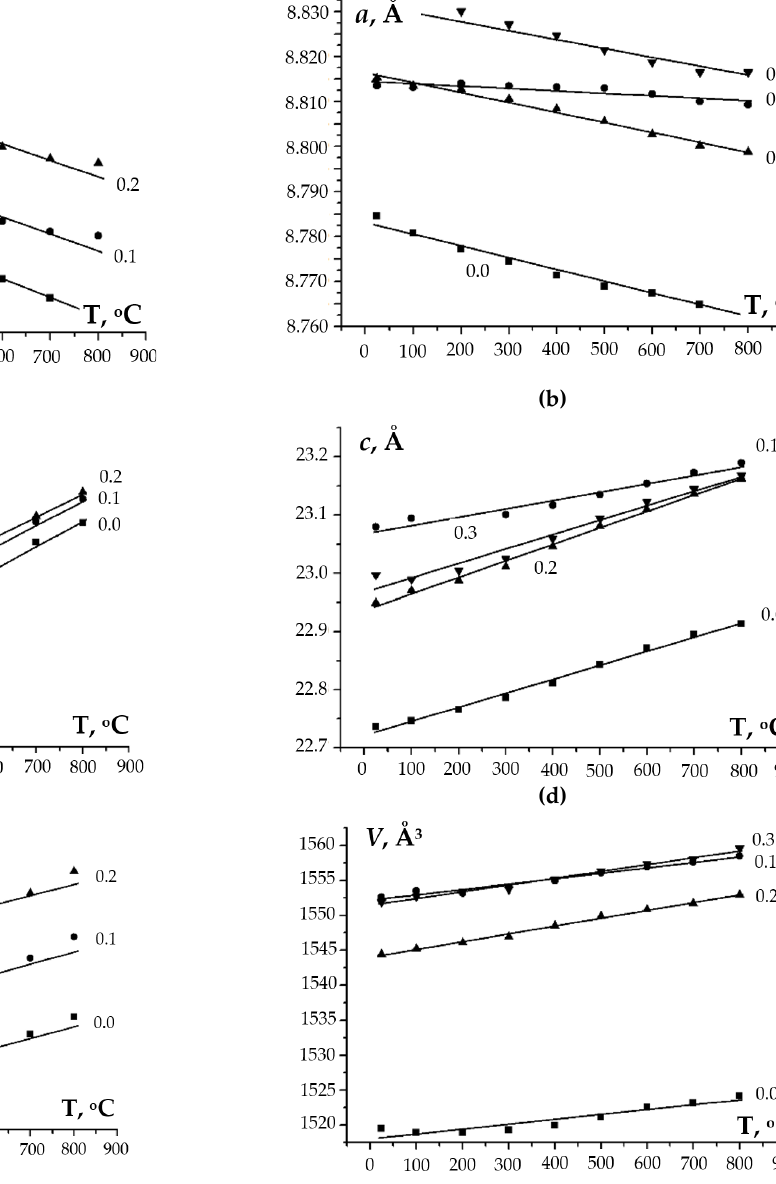
Figure 11. Temperature dependencies of the unit cell parameters a and c , and of the unit cell volume V of phosphates of Ca 1-x Zr 2 (PO 4 ) 3-x (XO 4 ) x , X = Mo ( a, c, e ), W ( b, d, f ); x = 0, 0.1, 0.2, 0.3.